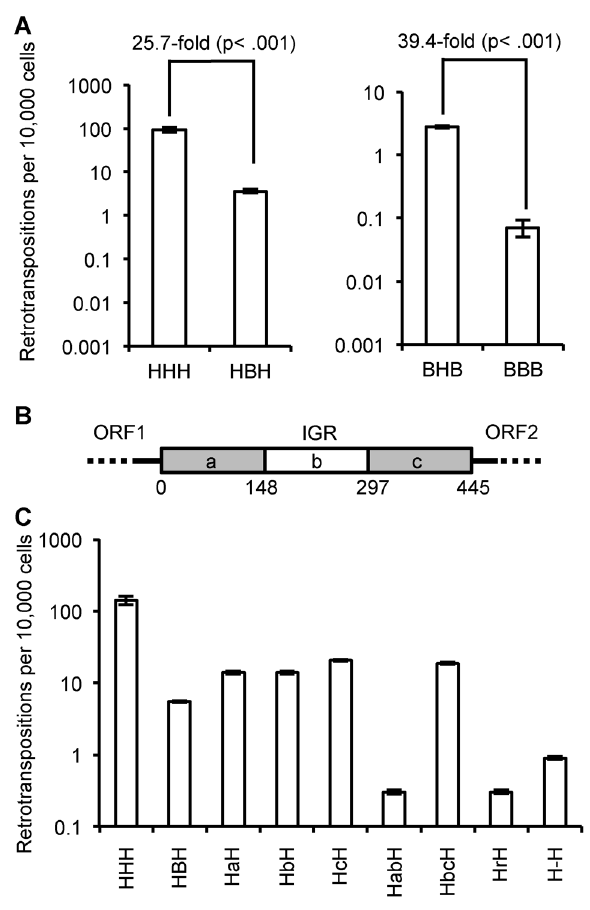
Figure 5. Effect of IGR on retrotransposition rate. (A) Heterol- ogous IGRs: replacing the human L1 IGR with a megabat version reduces the retrotransposition rate , 25.7-fold, while replacing the megabat IGR with a human L1rp IGR increases the retrotransposition , 39.4-fold. (B) Schematic presentation of the manipulation of the reconstructed megabat L1 IGR: the IGR was truncated in one-thirds represented by ‘a’, ‘b’ and ‘c’, respectively. Numbers below the scheme indicate the coordinates of the split points of the truncations on the IGR. (C) Manipulated IGRs were tested in all chimeric L1 backgrounds and the results were qualitatively similar. Data are shown for replacement of the human L1rp IGR (HXH); data for the remaining L1 backgrounds are shown in Figure S3. At least four plates were counted per construct. Constructs are named by their composition of the ORFs and IGR. The first character represents the source of ORF1 and the last character represents the source of ORF2: ‘H’ indicates human and ‘B’ indicates megabat. The middle characters represent the manipulation of the IGR: ‘a’, ‘b’ and ‘c’ indicate the truncated IGR parts the construct contains as illustrated in (B) in the order they are present in the construct. For example, ‘HabH’ indicates a construct with human L1rp ORFs and the first two thirds of the truncated megabat L1 IGR. Other IGR manipulations are also abbreviated: ‘r’ indicates a shuffled version of the megabat IGR of the same length and nucleotide composition, and ‘-’ indicates the megabat IGR with all the AUG start codons (excluding the start at the beginning of ORF2) mutated to